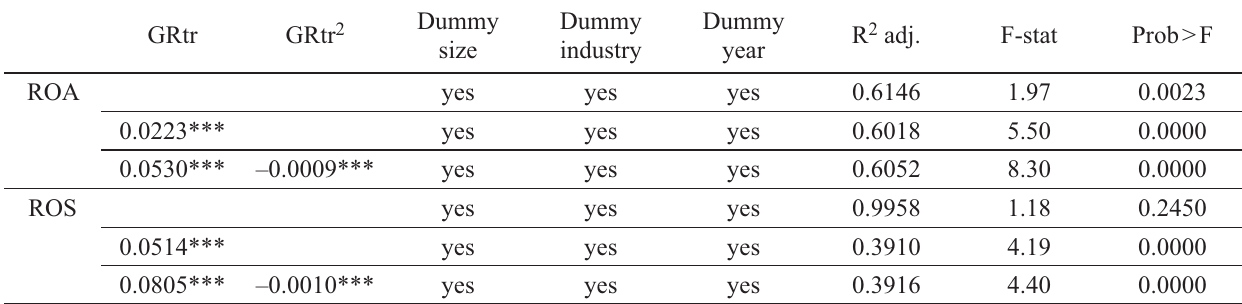
Table 2. Fixed effects models for the dependence of profi tability on the growth rate and control variables GRtr